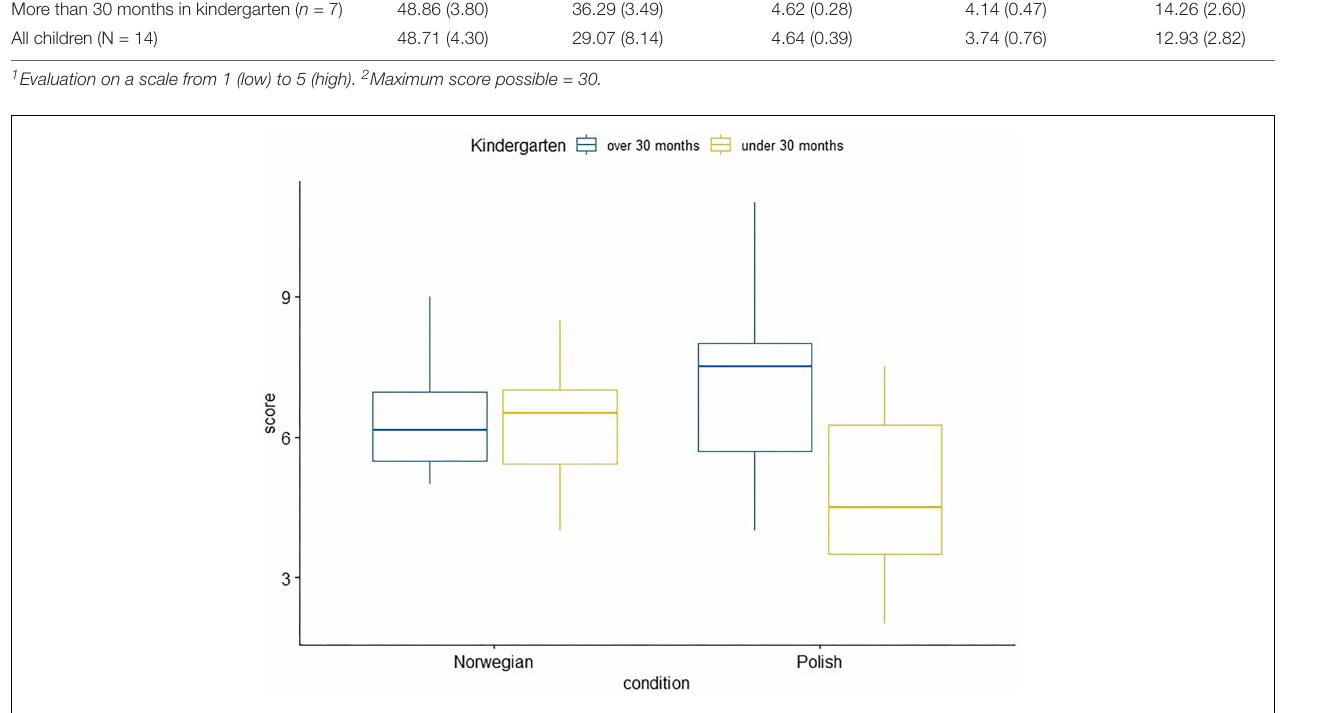
FIGURE 3 | Box plots of the combined vocabulary scores for the story read only in Norwegian versus in Polish first, coloured by time in kindergarten. Maximum score possible = 16. TABLE 3 | Mean scores (and standard deviations) for reading in Polish vs. reading only in Norwegian and for reading in Norwegian at home vs. reading in kindergarten only. Reading in Polish vs. reading in Norwegian only Reading in Norwegian at home vs. in kindergarten only Combined vocabulary Implicit comprehension Combined vocabulary Implicit comprehension